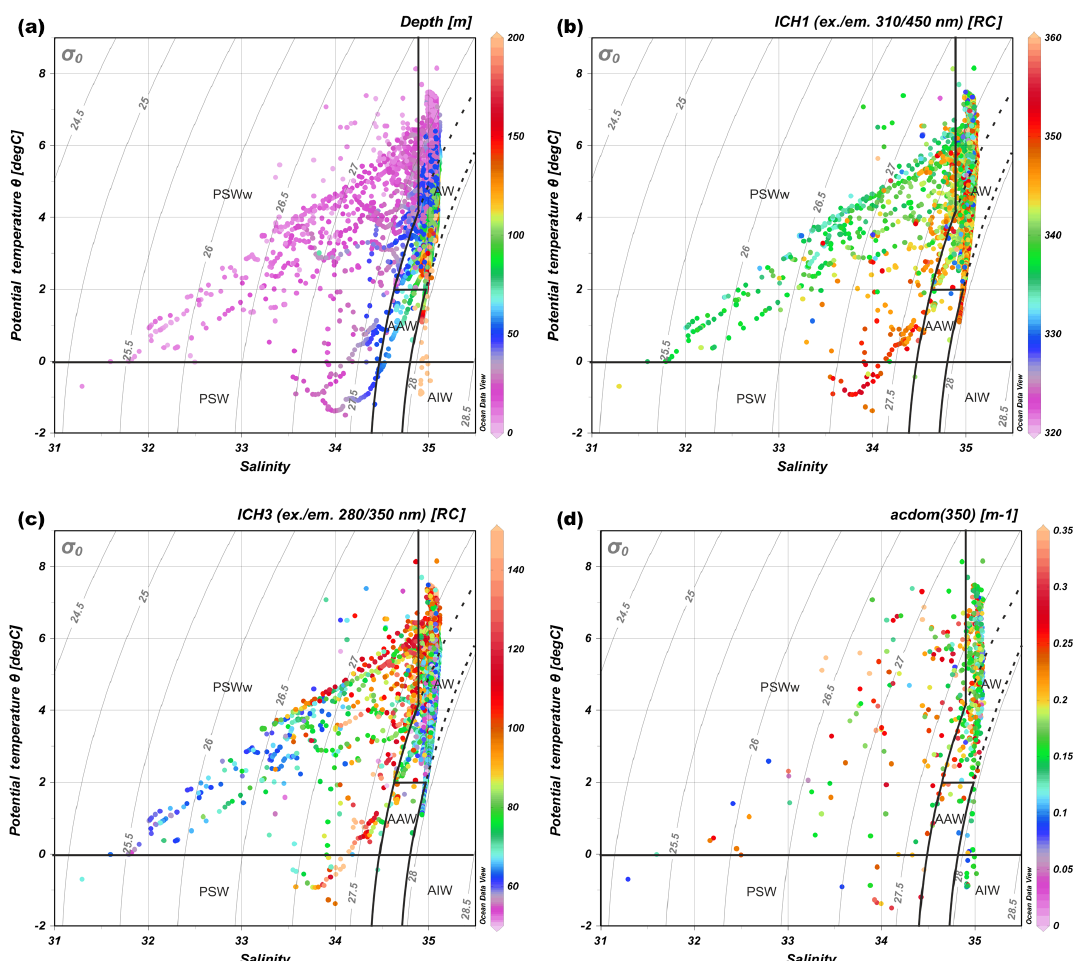
Figure 3. TS diagram of water mass distribution in the study area in 2013–2015. (a) Color bar represents depth (m). (b) Color bar represents humic-like fraction fluorescence intensity I CH1 (ex. = 310nm and em. = 450nm, RC). (c) Color bar represents protein-like fraction fluores- cence intensity I CH3 (ex. = 280nm and em. = 350nm, RC). (d) Color bar represents values of absorption coefficient at 350nm, a CDOM (350) (m − 1 ). The lower number of points in (d) resulted from fewer numbers of discrete water samples for determination of CDOM. Water